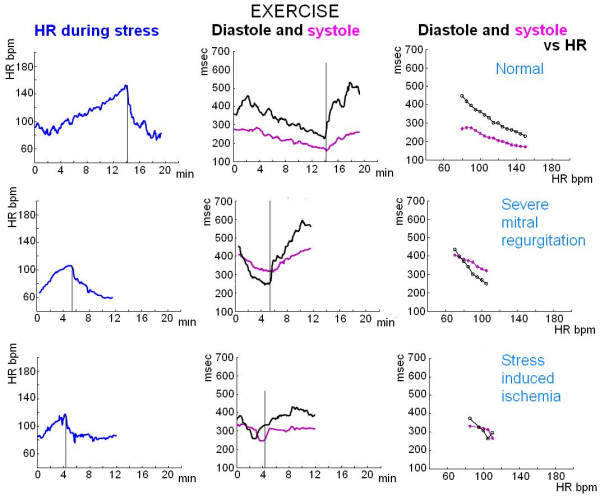
Exercise stress echo. Systolic (pink lines) and diastolic (black lines) times as a function of HR. Upper panel, a normal subject: systolic duration plotted as a function of HR demonstrates a slight linear decrease; duration of diastole demonstrates the most significant change. Middle panel, a patient with severe mitral regurgitation and stress induced severe pulmonary hypertension; the test was stopped at low stress load due to limiting dyspnoea without stress induced ischemia: prolonged systolic time with systolic/diastolic time reversal occurred during stress. Lower panel, a patient with stress induced ischemia at low stress load: at ischemia systole lengthens with systolic/diastolic time reversal.